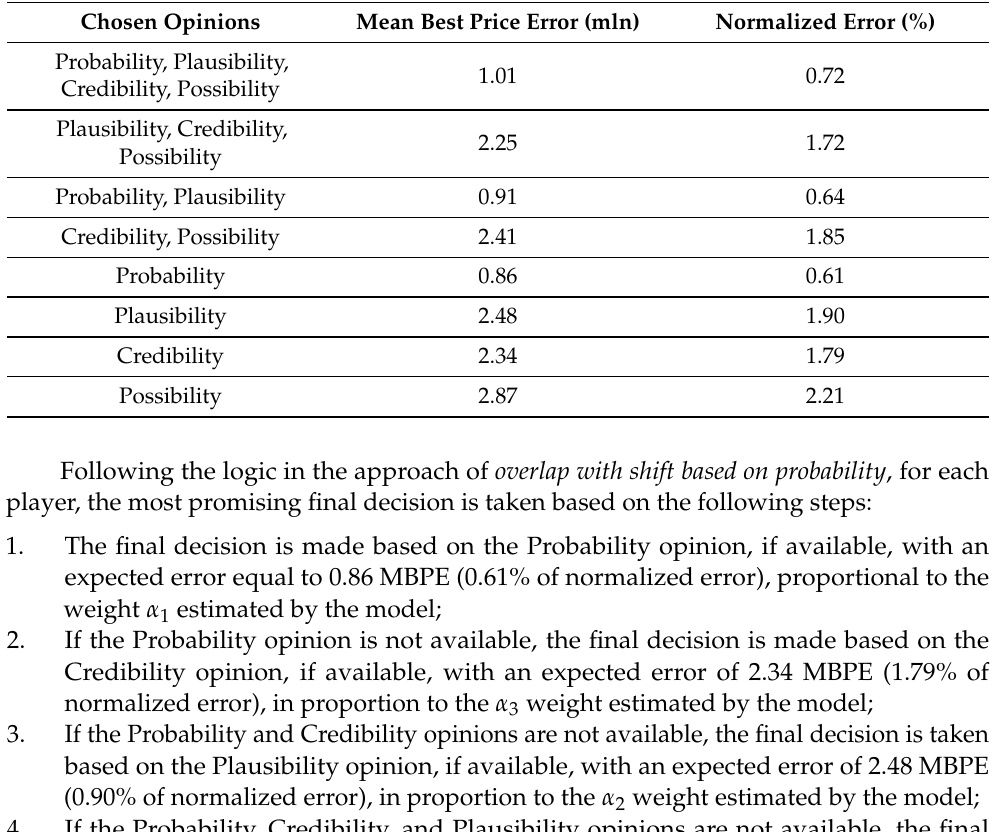
Table 2. Performance in predicting the best price by considering different sets of opinions and the most important features. Model Evaluation Considering the Most Important